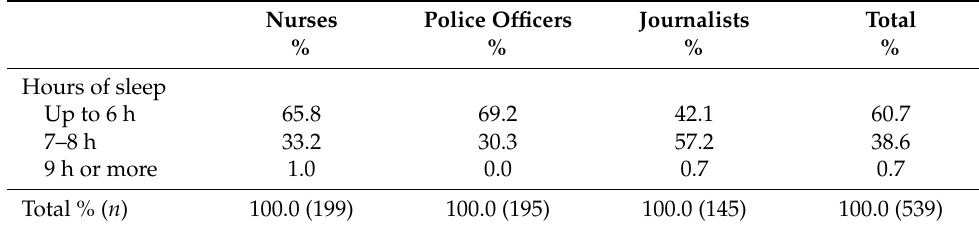
Table 3. Number of hours of sleep per day on working days.